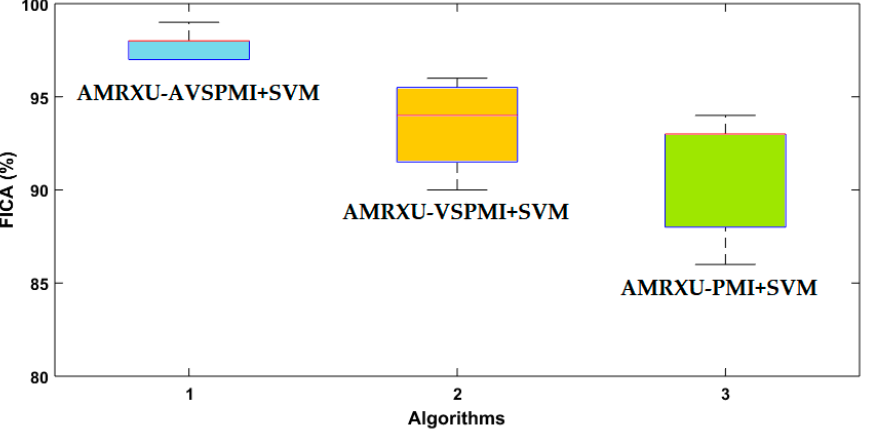
Figure 8. The boxplots of the FICA metric over 10 experiments for the AMRXU-AVSPMI+SVM, AMRXU-VSPMI+SVM, and AMRXU-PMI+SVM.